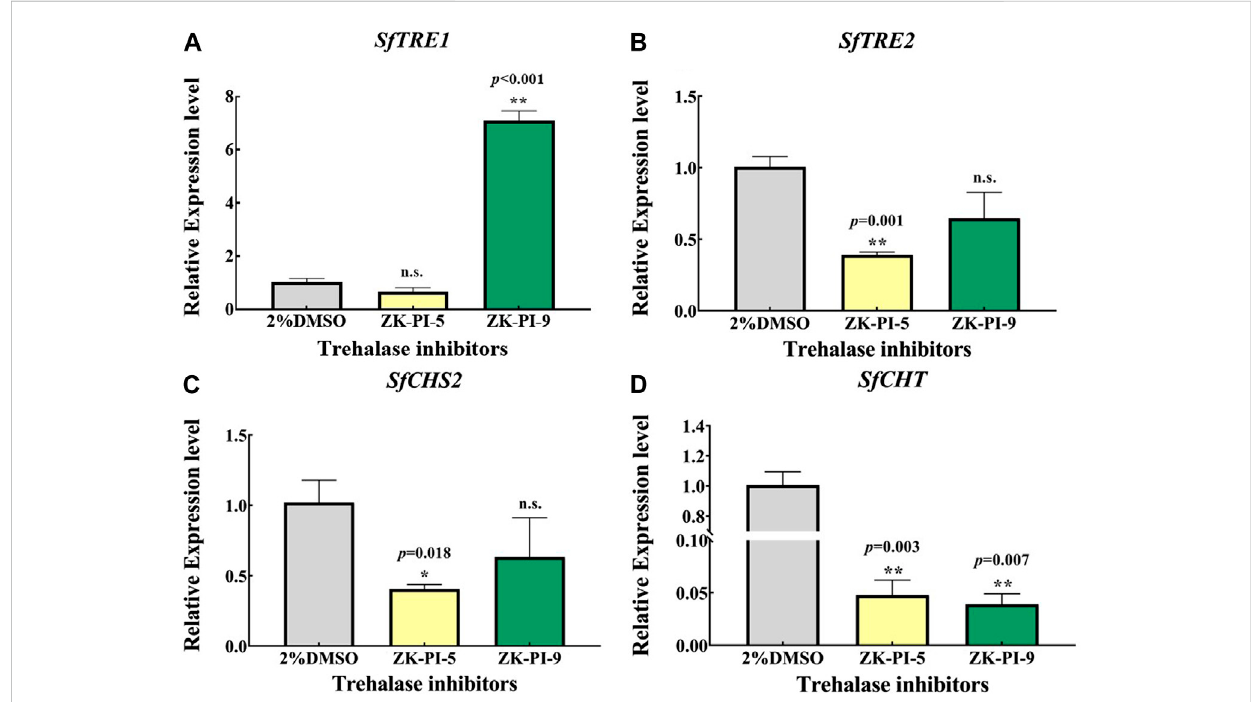
FIGURE 3 The mRNA relative expression levels of TRE1 (A) , TRE2 (B) , CHS2 (C) , and CHT (D) genes in S. frugiderda after injection of both trehalase inhibitors over48 h.Expressionoftwotrehalosemetabolismpathwaygenes (A,B) andtwochitinmetabolismpathwaygenes (C,D) after48 h,levelsweremeasured using q-RT-PCR. TRE1 , soluble trehalase; TRE2 , membrane-bound trehalase; CHS2 , chitin synthase 2; CHT , chitinase. Values are presented as the means ± SE. * p < 0.05 denotes signi fi cant differences. ** p < 0.01 denotes extremely signi fi cant differences, n.s.: not signi fi cant (independent- samples t